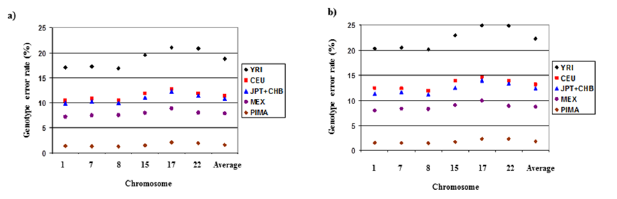
Figure 1. Genotype error rates according to reference popu- lation when a) 1% or b) 20% of genotypes were masked.